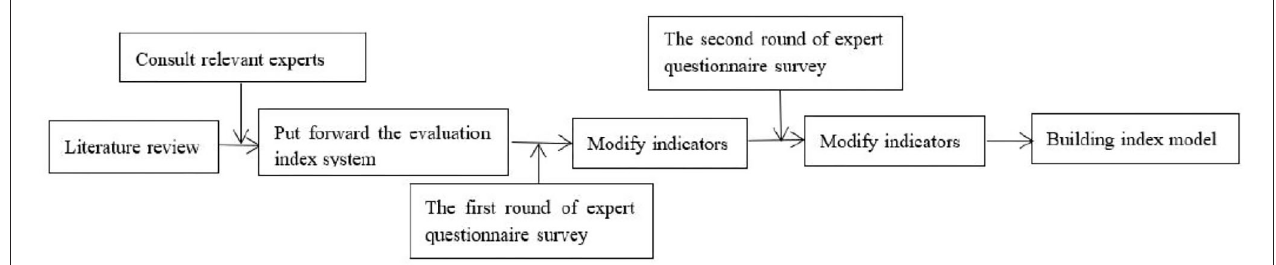
FIGURE 1 | Index screening